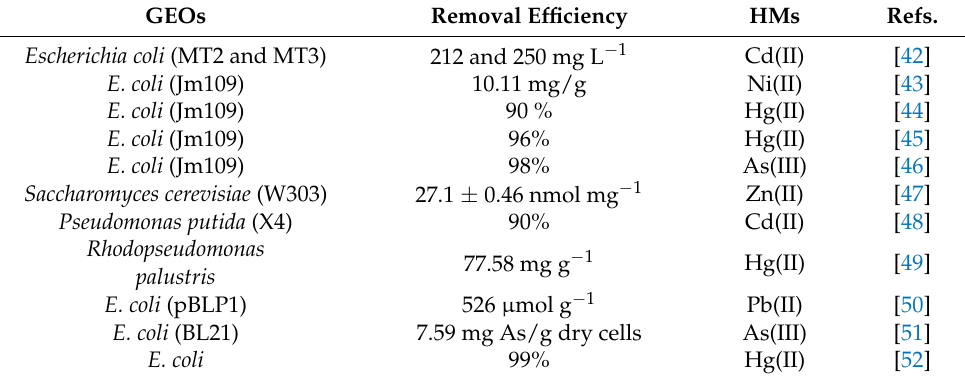
Table 1. Some selected GEOs investigated for the removal of HMs. GEOs Removal Efficiency HMs Refs.